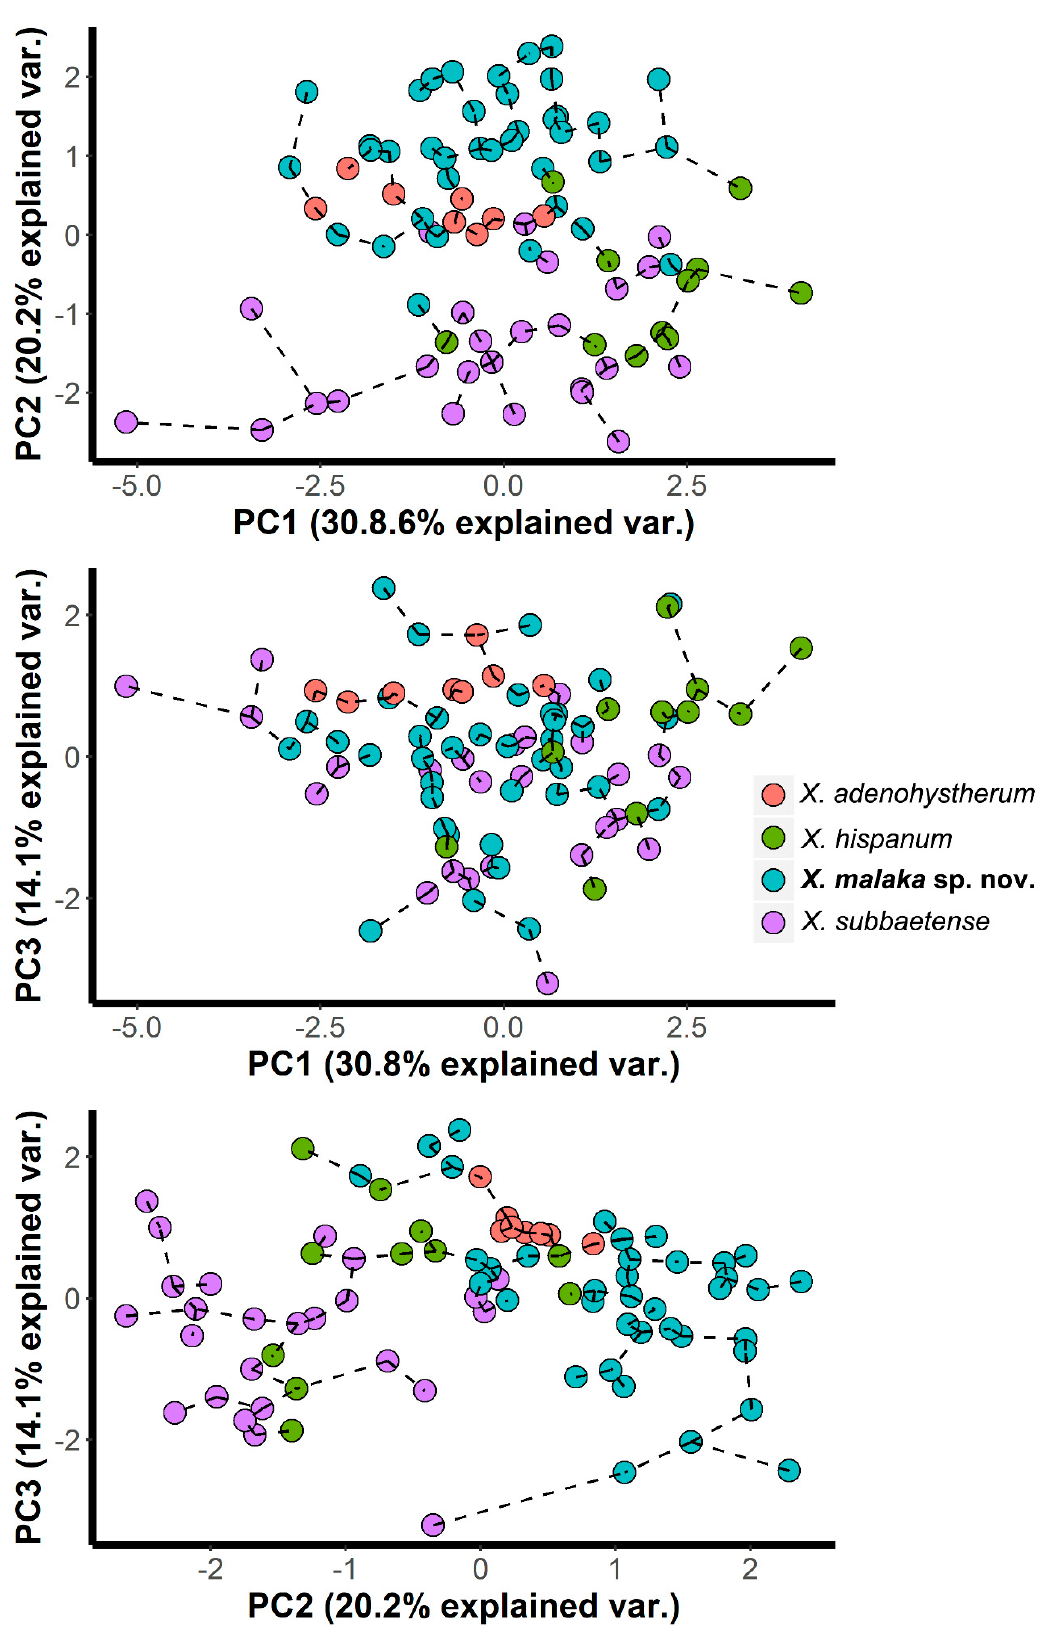
Figure 2. Principal component analysis on morphometric characters to characterize Xiphinema hispanum- complex with a superimposed minimum spanning tree (based on Euclidean